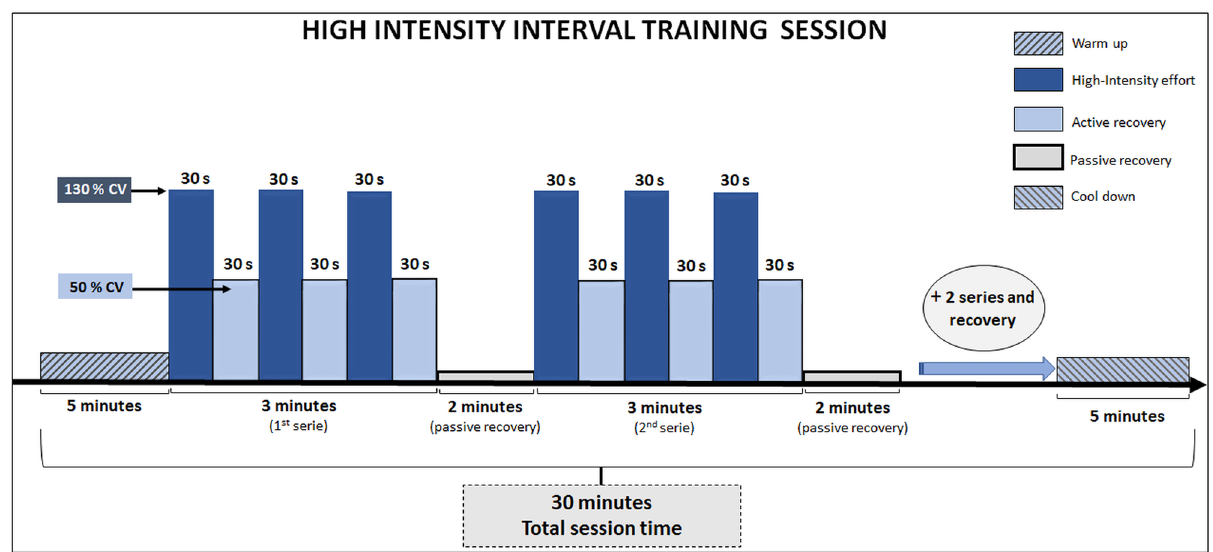
Figure 1. Illustration of a HIIT session including all information about intensity, volume, series, and recovery. CV : critical